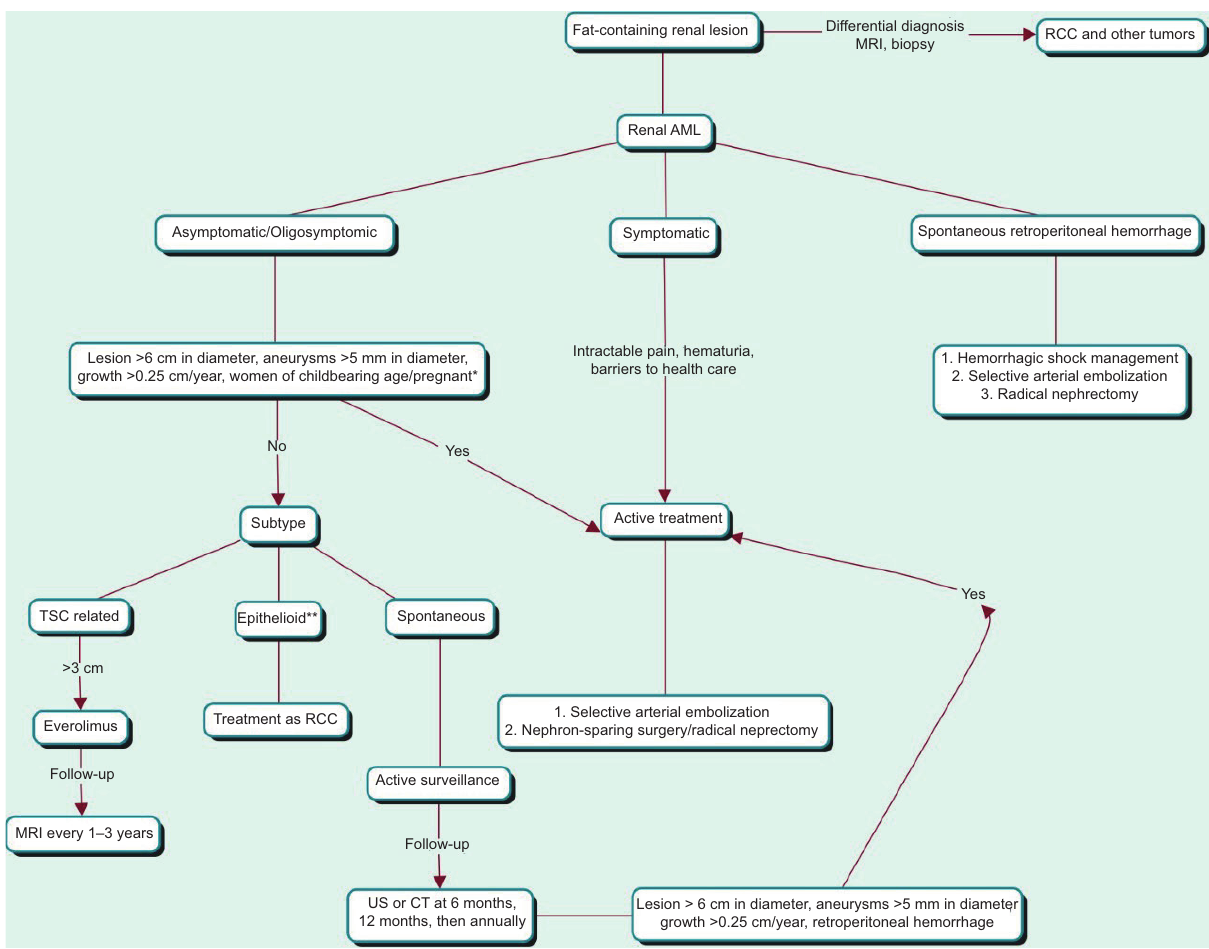
Figure 2: Proposed updated management algorithm. RCC – renal cell carcinoma; AML – angiomyolipoma; TSC – tuberous scle- rosis complex; MRI – magnetic resonance imaging; US – ultrasound; CT – computerized tomography. *Associated with other risk factors, according to medical criteria. **See characteristics and risk factors in “epithelioid